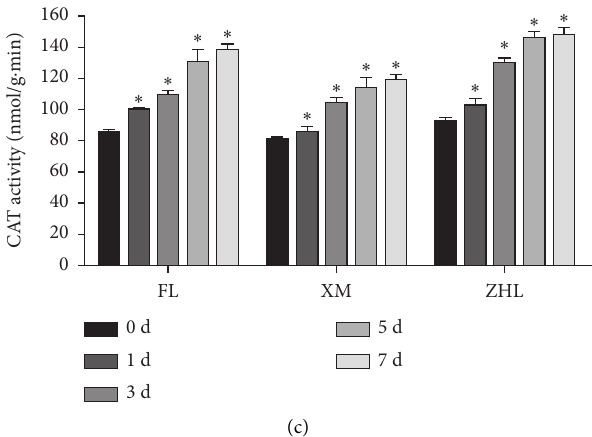
Figure 4: The changes of enzyme activities of SOD (a), POD (b), and CAT (c) of the annual branches of the three varieties of pitaya with cold treatment. “ ∗ ” indicates the enzyme activity changes of SOD, POD, and CAT with a significant difference at p < 0 . 05 compared with the control